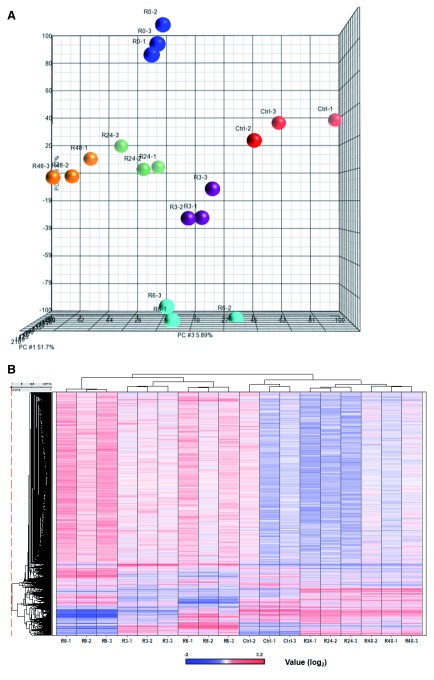
Technical validation of microarray data.The three biological replicate samples of microarray data were shown to cluster together by using (
A) principal component analysis (PCA) and (
B) unsupervised hierarchical clustering of the RNA microarray data of eighteen samples.